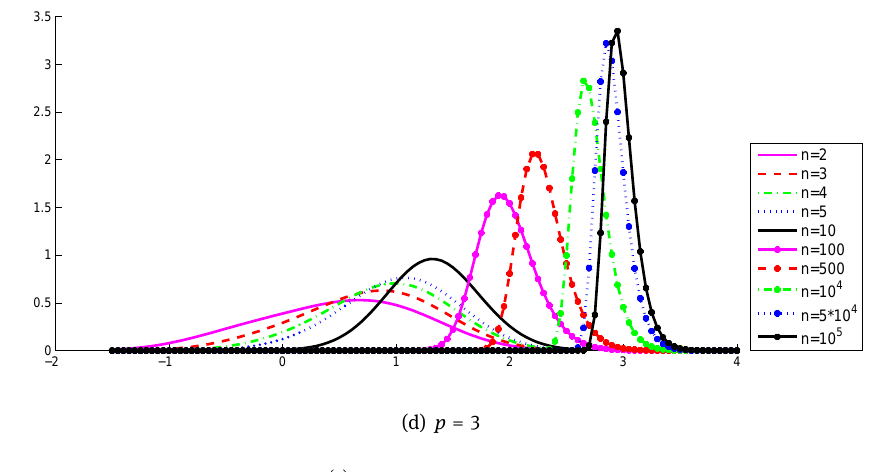
Figure 6: Maximum pdf f n : n for different n and dg g ( n )